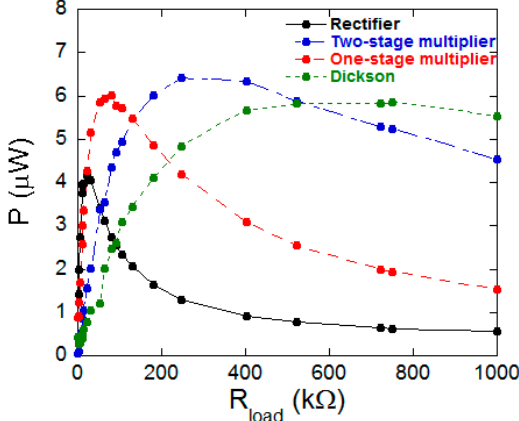
Figure 7. The output electric power as a function of the load resistance for all the studied energy harvesting circuits.